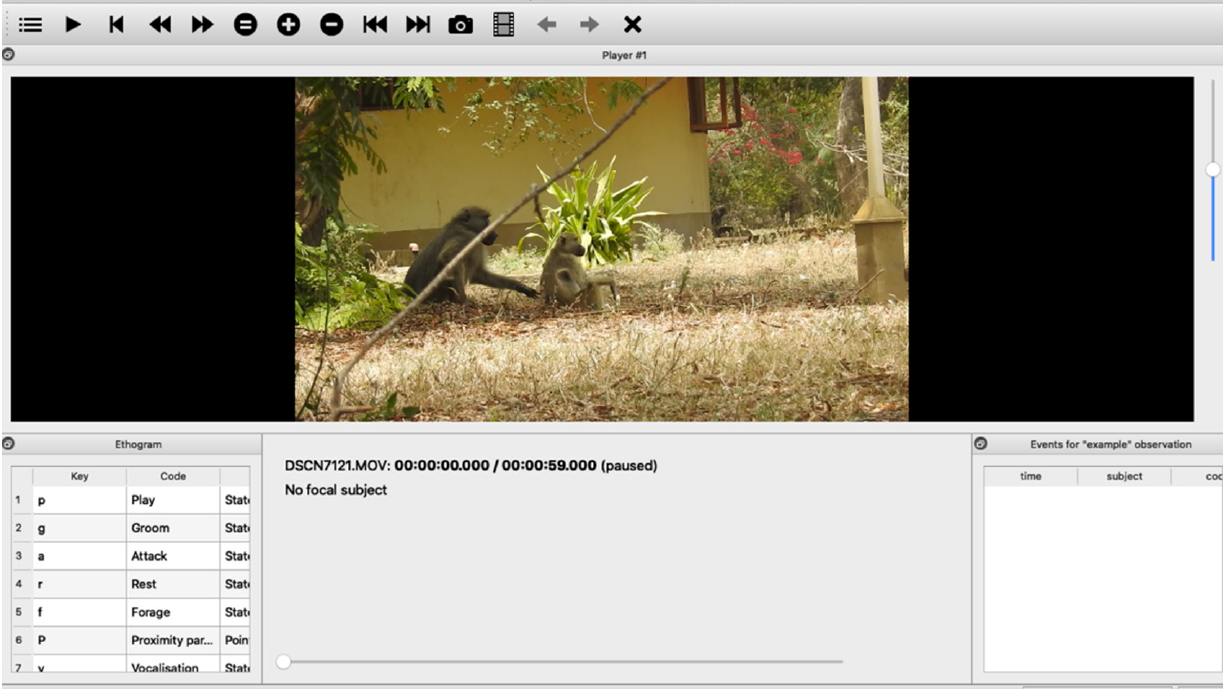
Table 3. Number of observations by parting type .